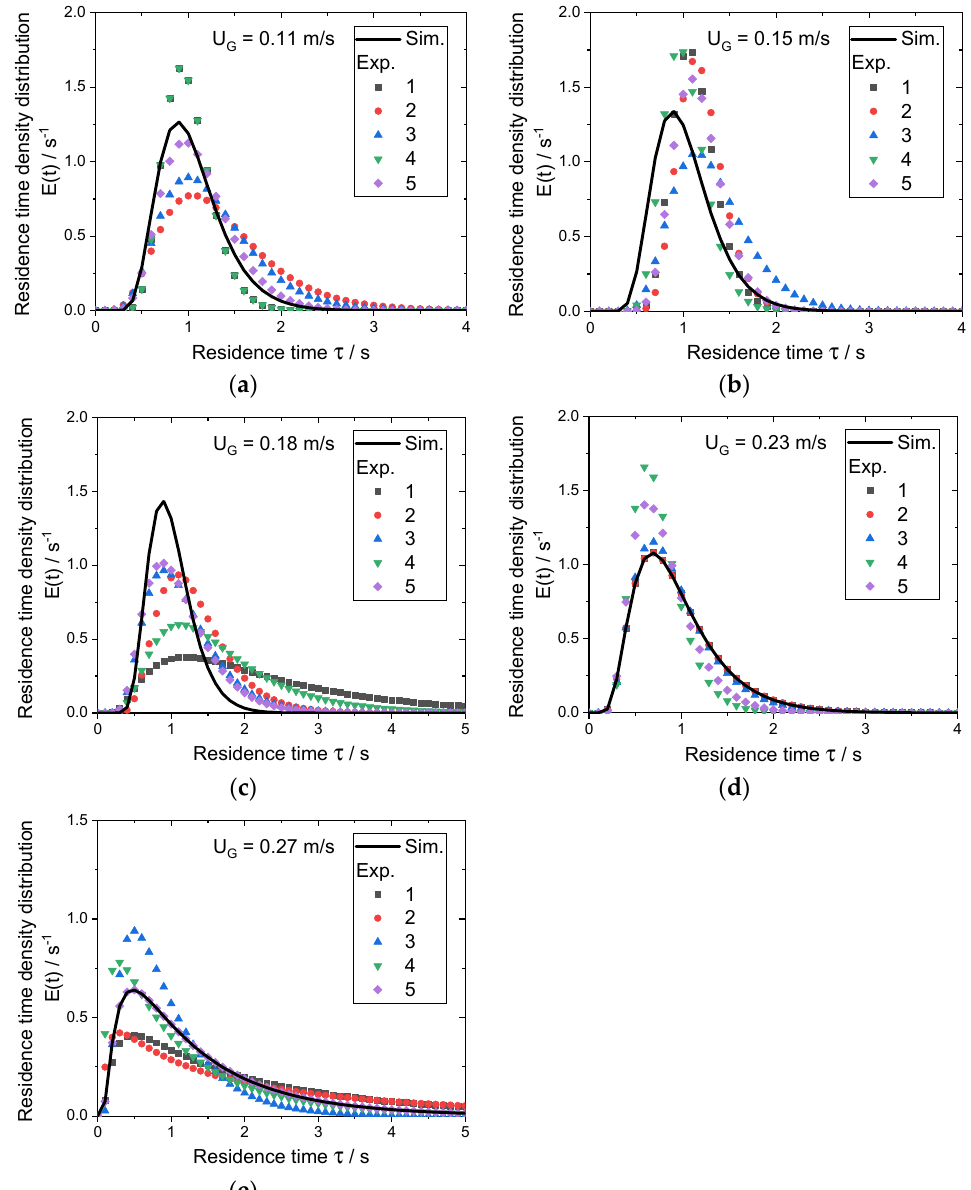
Figure 5. Experimental and numerical particle residence time density distributions under different sheath gas velocities: ( a ) U G = 0.11 m/s; ( b ) U G = 0.15 m/s; ( c ) U G = 0.18 m/s; ( d ) U G = 0.23 m/s; ( e ) U G = 0.27 m/s.